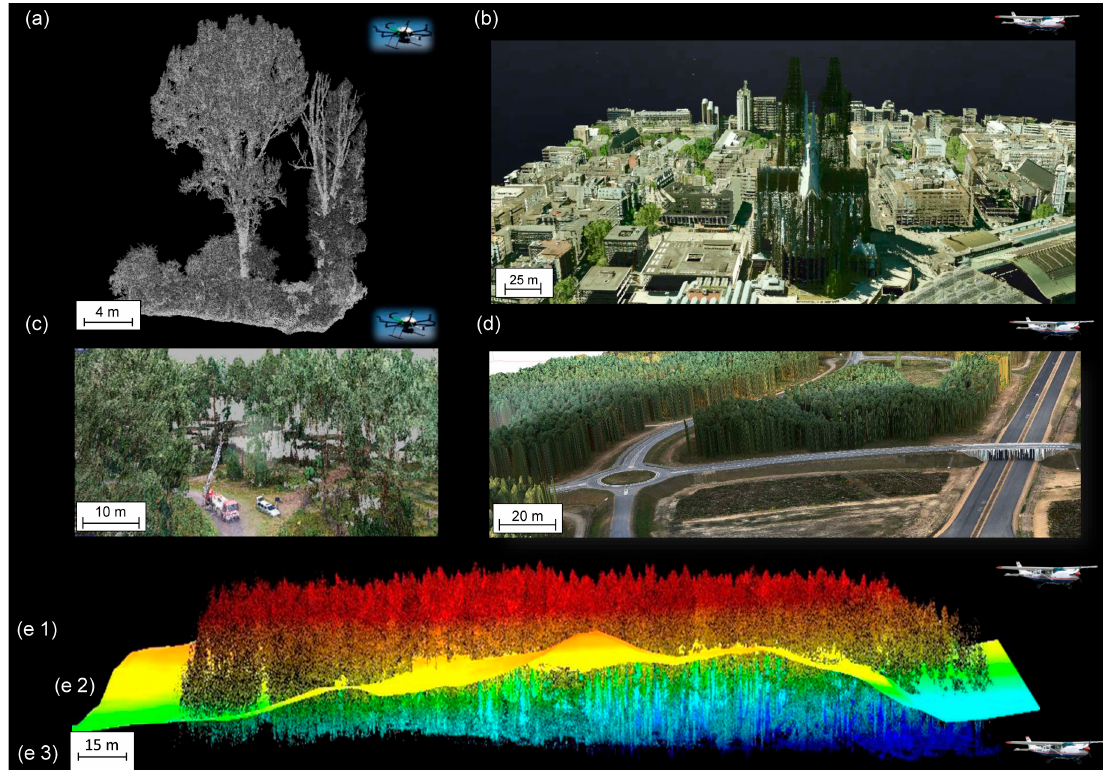
Figure 4. Digital Surface Model (DSM) recorded by different sensors and mounted on various RS platforms: ( a ) DSM—Terrestrial Laser Scanner—LiDAR (RIEGL VUX-1), point density (250 points/m 2 ), on UAV (RiCopter), ( b ) DSM with Terrestrial Laser Scanner—LiDAR (RIEGL VUX-1), point density (30 points/m 2 ), on airplane, Cologne, Germany, ( c ) DSM—RGB (Sony NEX-7 RGB) image data-based point cloud (natural colour), on UAV (modified after Thiel et al. [86], ( d ) DSM—RGB image based point cloud, on airplane, ( e ) DSM comparisons of ( e1 ) a Terrestrial Laser Scanner (TLS) DSM point cloud, ( e2 ) a TanDEM-X DSM (satellite) and ( e3 , blue color) the DTM from the Federal LiDAR survey (airplane). The maximum extent of the TLS dataset is approximately 200 m and the resolution of the TanDEM-X DSM is 5 × 5 m 2 . ( e2 ) Note that the TanDEM-X DSM is located within the canopy, illustrating the true backscatter center of the RADAR returns.